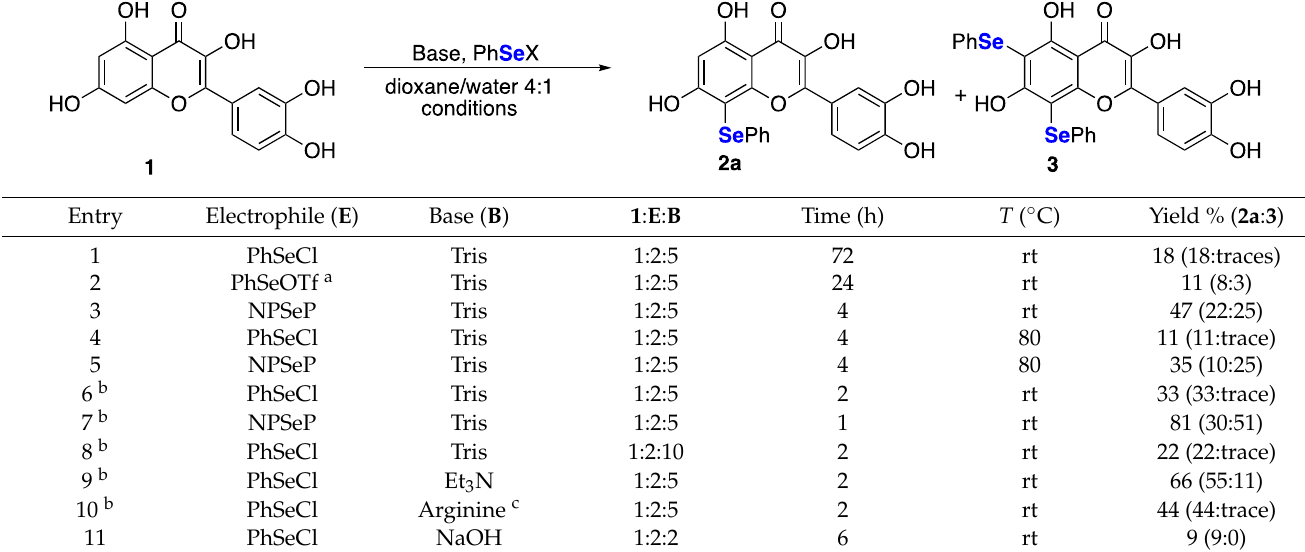
Table 1. Optimization of the reaction conditions.